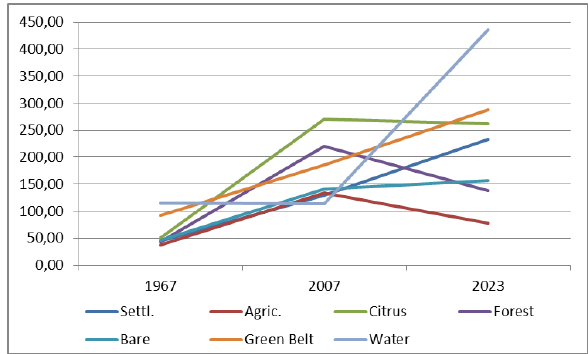
Figure 12. Mean Euclidian Nearest Neighbour Distance (ENN-MN) metrics.